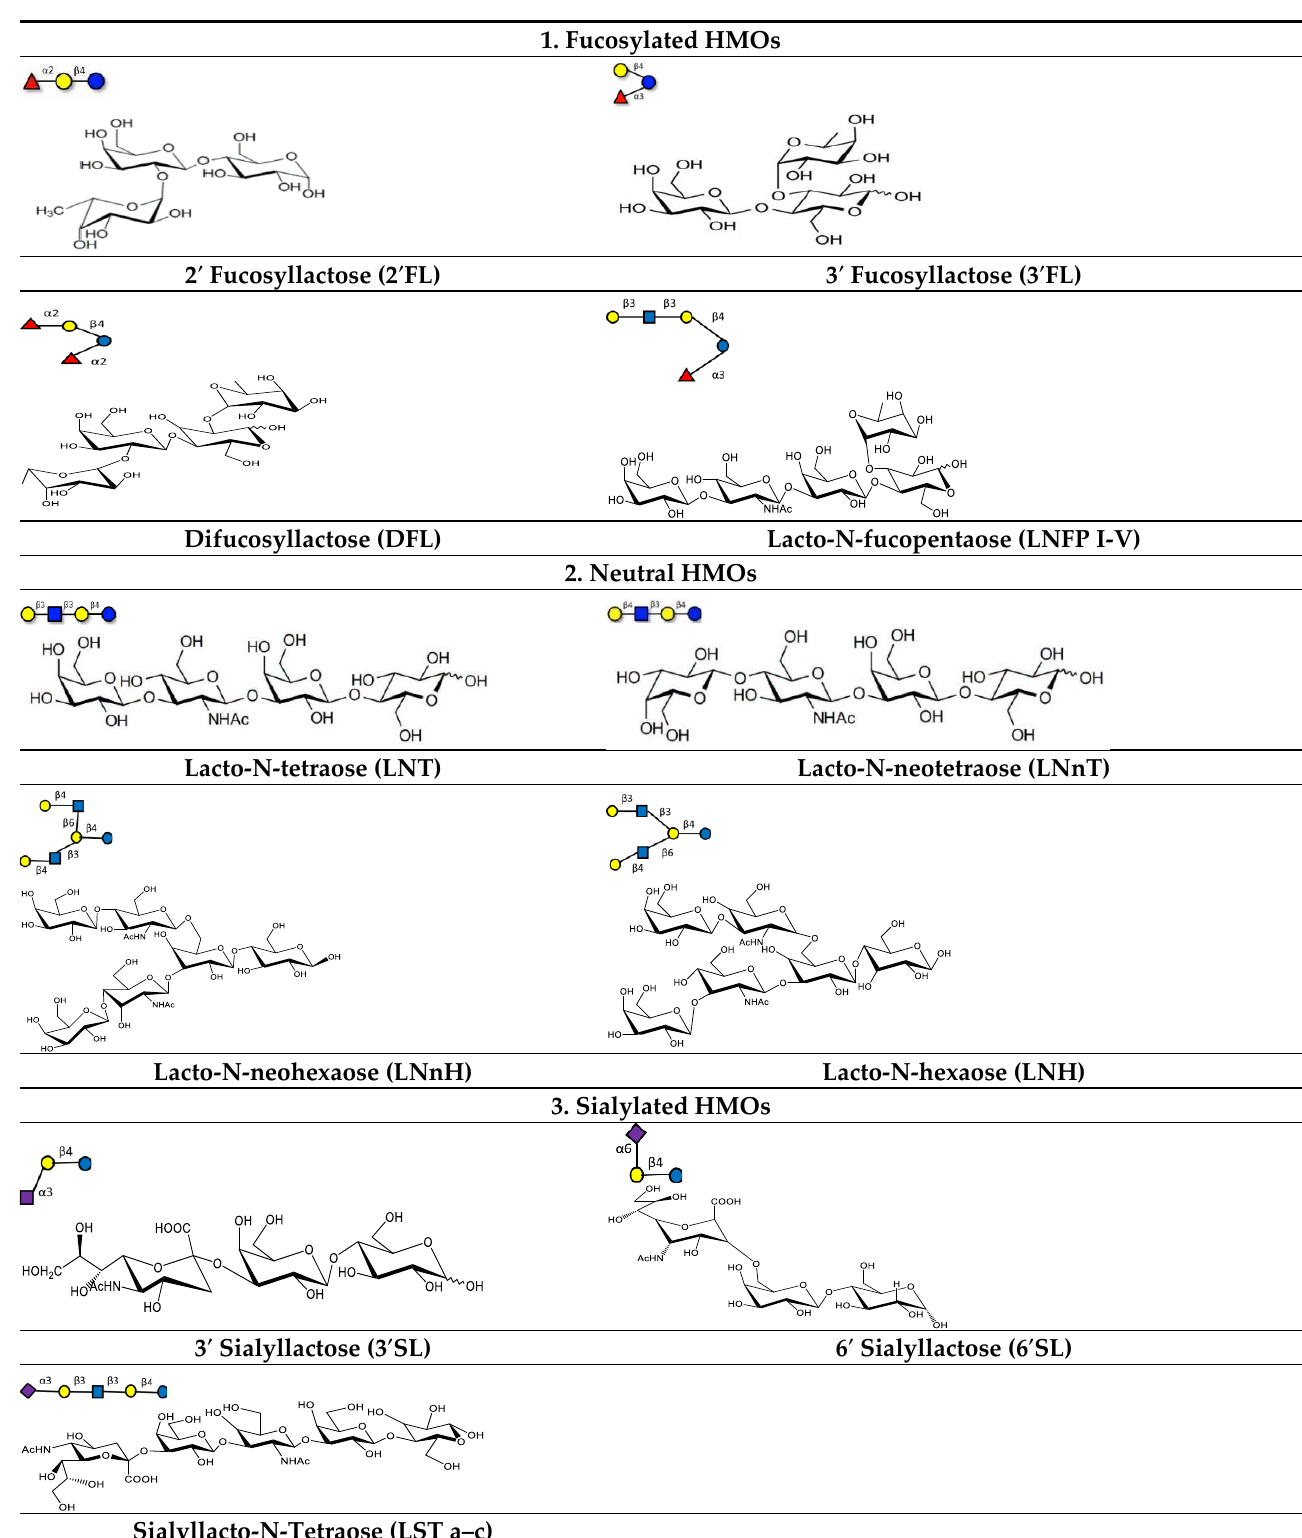
Figure 3. Different types of fucosylated, neutral, and sialylated HMO molecules. Neutral HMOs comprise 42 – 55% of the total HMOs. Lacto-N-tetraose (LNT) is an example of this class [32,53]. Lacto-N-tetraose (LNT) is an amino tetrasaccharide comprising β -D-galactose, N-acetyl-b-D-glucosamine, β -D-galactose, and D-glucose residues in a